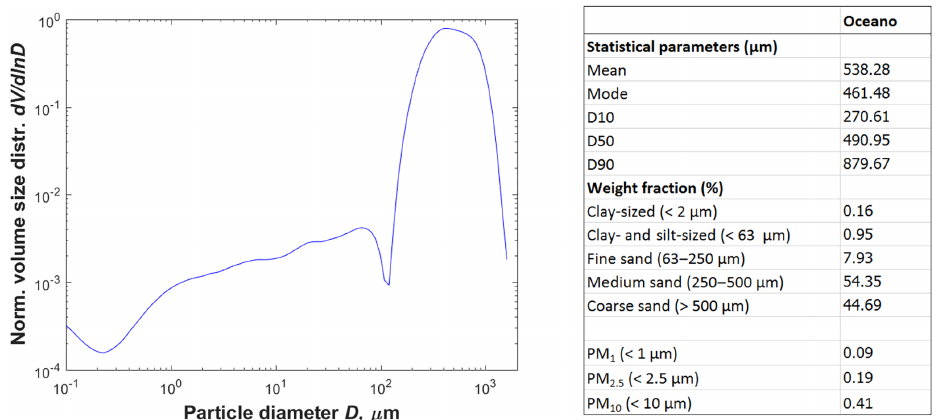
Figure 7. Normalized volume particle size distribution (PSD) of sand samples collected from the Oceano field site. Statistical parameters of the PSD are reported in the table to the right. D10, D50, and D90 refer to cut-off diameters of the 10th, 50th, and 90th percentile of sample grains by mass, respectively. Note that the values are averages of four samples with two collected from the tower location and two from 100m upwind.